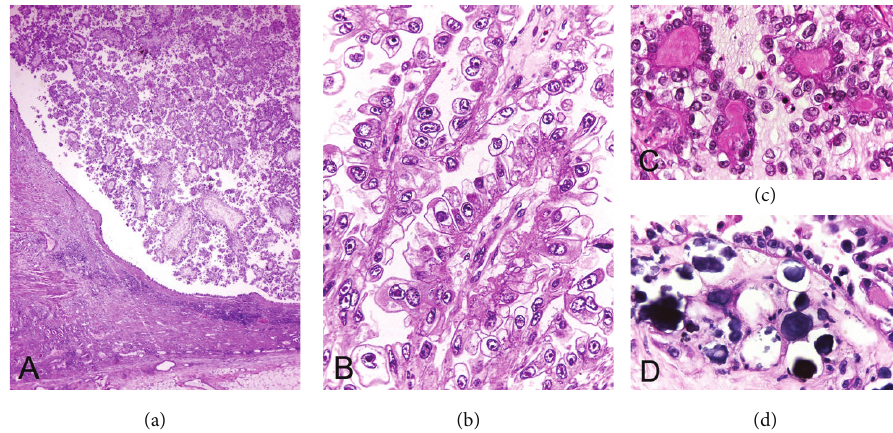
Figure 1:Clear cell adenocarcinoma. (a)Exophytic papillary growth of adenocarcinoma in dilated pelvicalyceal systemwith adjacent atrophic renalparenchyma(lowerleft).(b)Thepapillarystructuresarelinedwithhobnailcellswithlargeroundnucleiandclearcytoplasm.(c)Deposits of hyaline material in the stroma of the papillae. (d) Psammoma bodies are focally present.